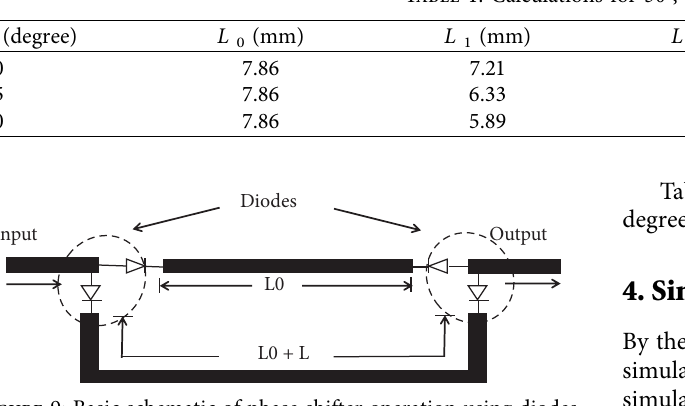
Figure 8: (a) Eight elements array with 0 degree phase diference, (b). Four sub arrays. Table 1: Calculations for 30 ° , 45 ° , and 90